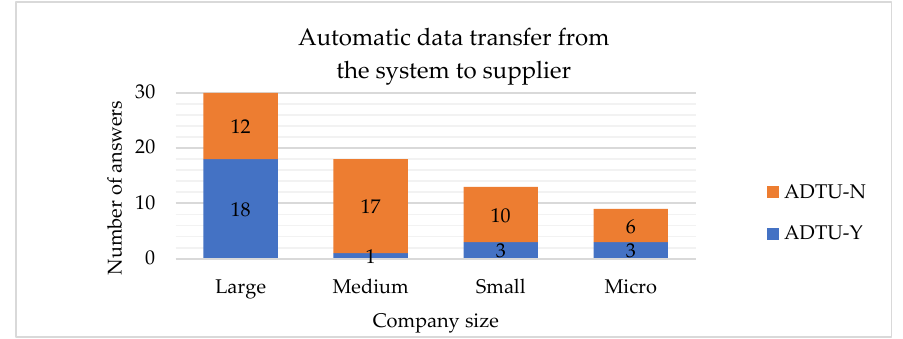
Figure 24. Number of companies having automatic data transfer between the internal systems implemented (ADTI-Y) or not (ADTI-N) by company size.